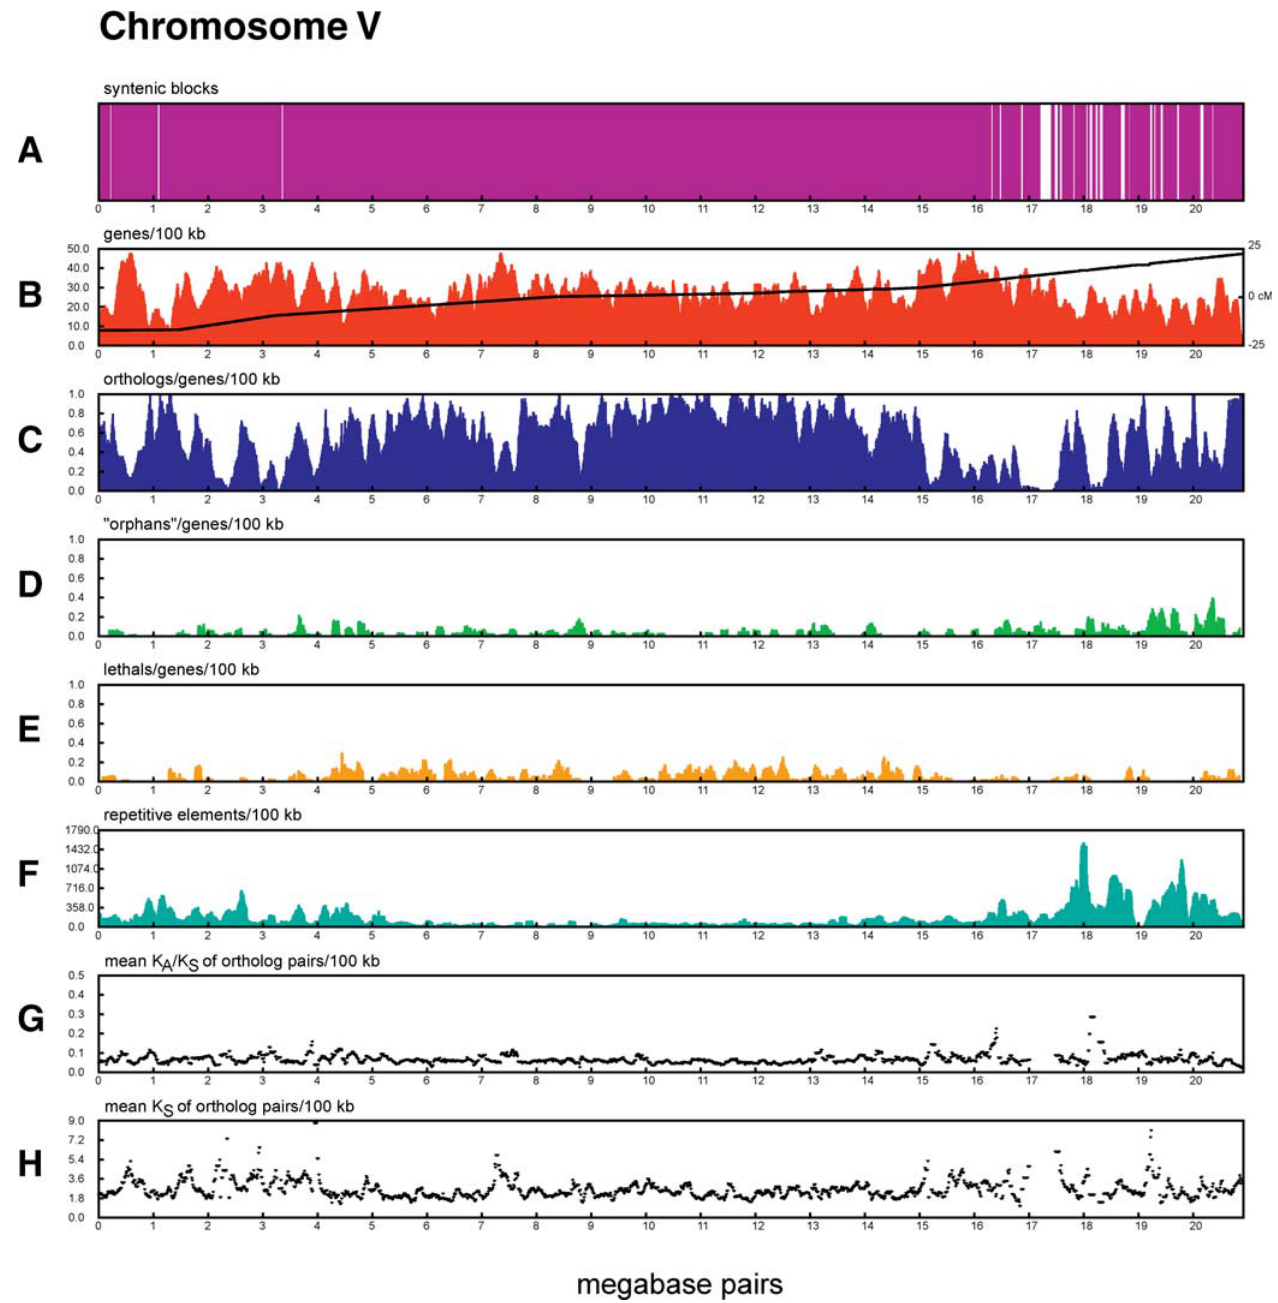
Figure 6. Evolutionary Divergence across C. elegans Chromosome V Each panel corresponds to a C. elegans chromosome, and the individual tracks show different measurements of evolutionary divergence. (A) Regions of synteny (colinearity) between C. elegans and C. briggsae . White areas correspond to areas where the two genomes could not be aligned owing to divergence and are more abundant in the chromosome arms. (B) C. elegans gene density and genetic map position. Gene density is plotted as a histogram, showing a relatively uniform distribution of genes across each chromosome. The relationship of the position of genes on the genetic map to their position on the sequence is superimposed on the y- axis. Steeper slopes in this plot indicate higher rates of meiotic recombination. Inflection points in the genetic map plot reflect the division of the chromosomes into recombinationally active ‘‘ arms ’’ and recombinationally slow ‘‘ centers. ’’ (C) C. briggsae/C. elegans orthologs normalized for gene density in 100 kbp sliding windows. Prominent regions of low ortholog density are seen on chromosome arms. (D) C. elegans ‘‘ orphans, ’’ genes with no significant protein similarity in C. briggsae or the non- C. elegans portion of SwissProt. This histogram has been normalized for gene density in 100 kbp sliding windows. Spikes in orphan density seem to correlate with regions of low ortholog density. (E) C. elegans genes that mutate to lethality or are lethal in RNAi screens, in 100 kbp sliding windows normalized to overall gene density. This track shows the distribution of essential genes and demonstrates their tendency to cluster in the chromosome centers. (F) Repetitive elements, binned in 100 kbp sliding windows. Repeat-rich regions correlate with both the absence of significant syntenic coverage and ortholog-poor regions. (G) The K A /K S ratio in ortholog pairs. Lower values indicate greater levels of purifying selection. (H) The rate of K S within ortholog pairs, in 100 kbp sliding windows. DOI: 10.1371/journal.pbio.0000045.g006 PLoS Biology | http://biology.plosjournals.org Volume 1 | Issue 2 | Page